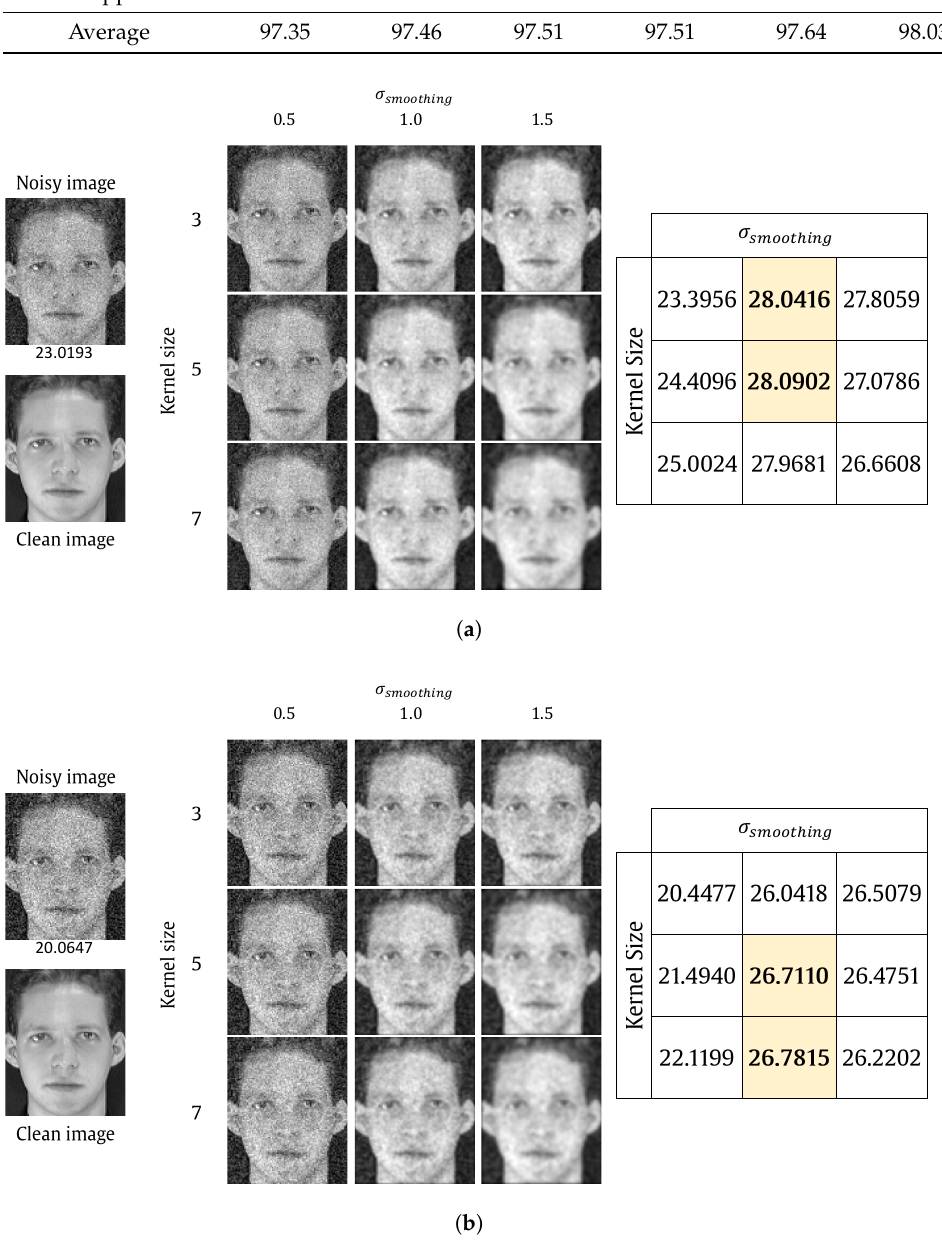
Figure 4. PSNR values for smoothing kernel test using Gaussian noise with standard deviation of ( a ) 0.01 and ( b )